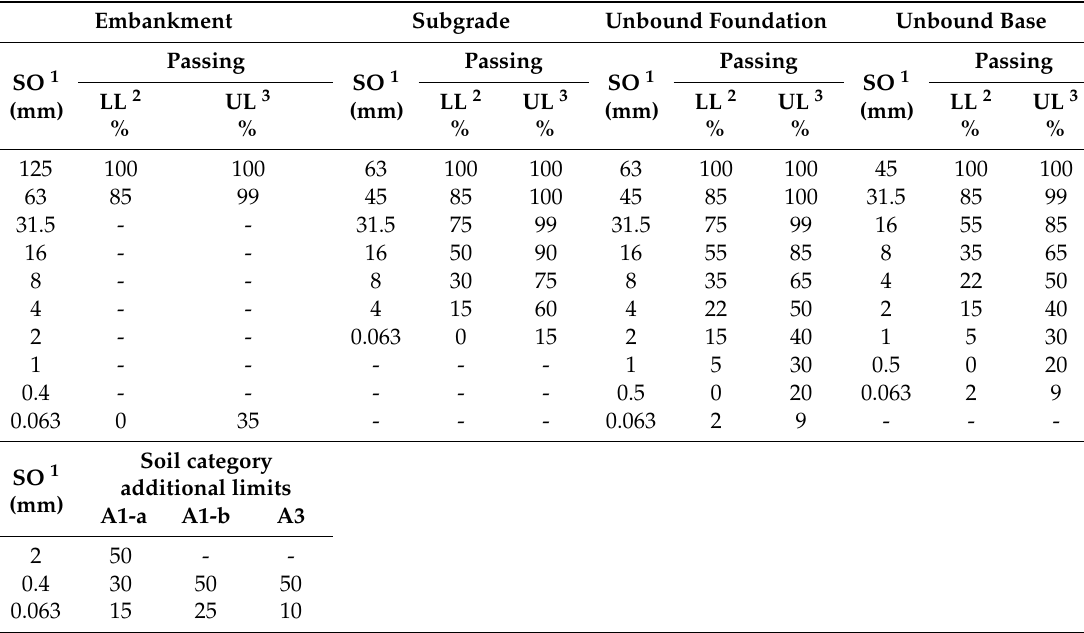
Table 3. Grading envelope requirements of unbound mixtures made of recycled